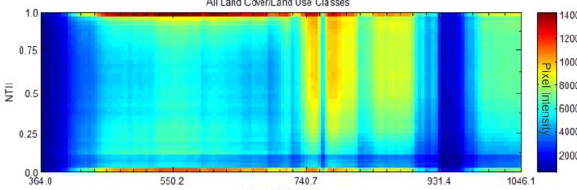
Figure 4. Mean pixel intensity vs. the NTII and wavelength.